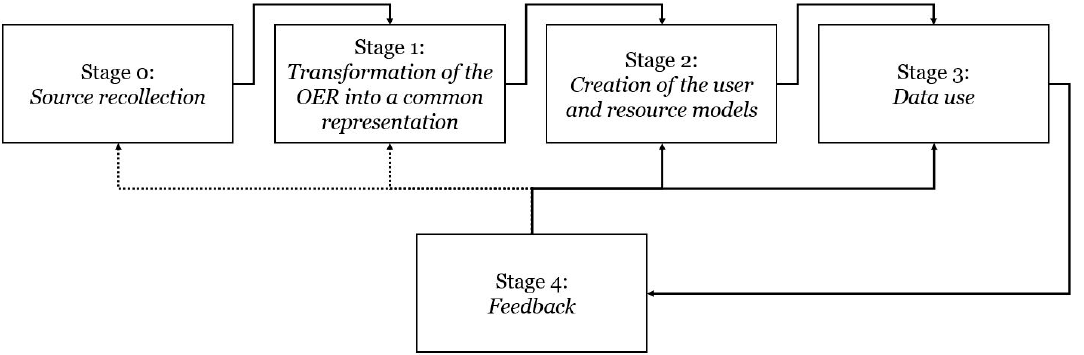
Figure 1. A diagram of the different stages of the model. The dynamic nature of the recommendation process generates a potentially never-ending